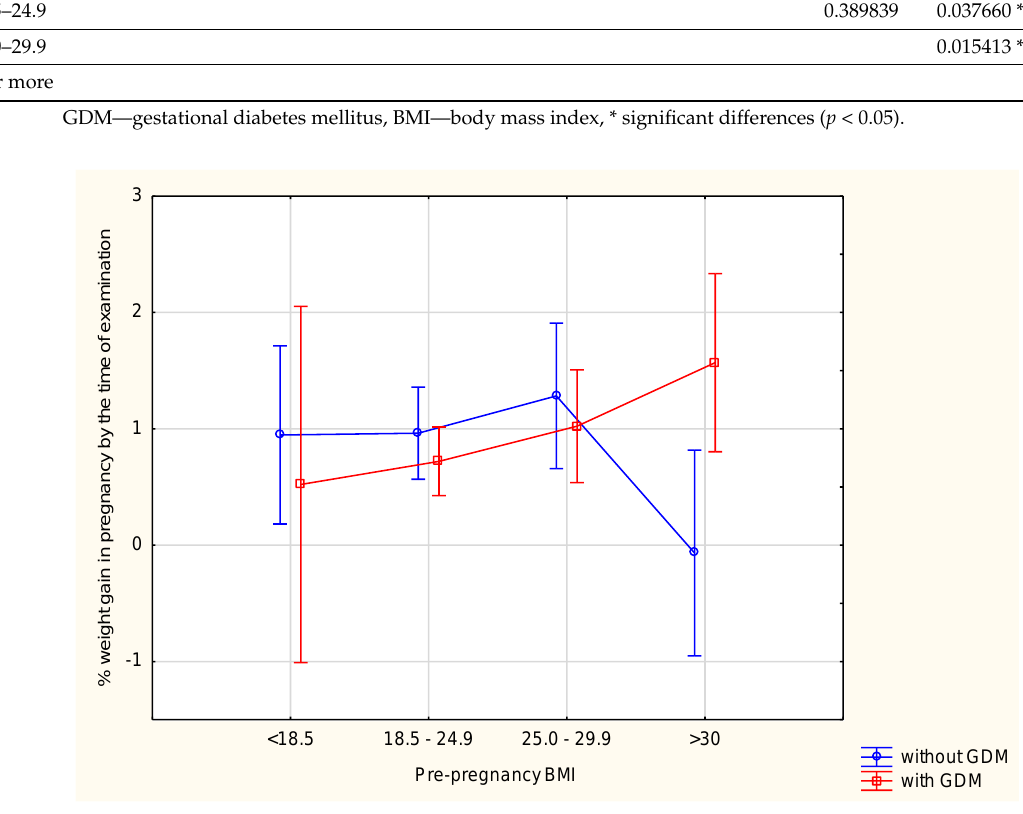
Analysis of the percentage of weight gain during the entire pregnancy showed dif-